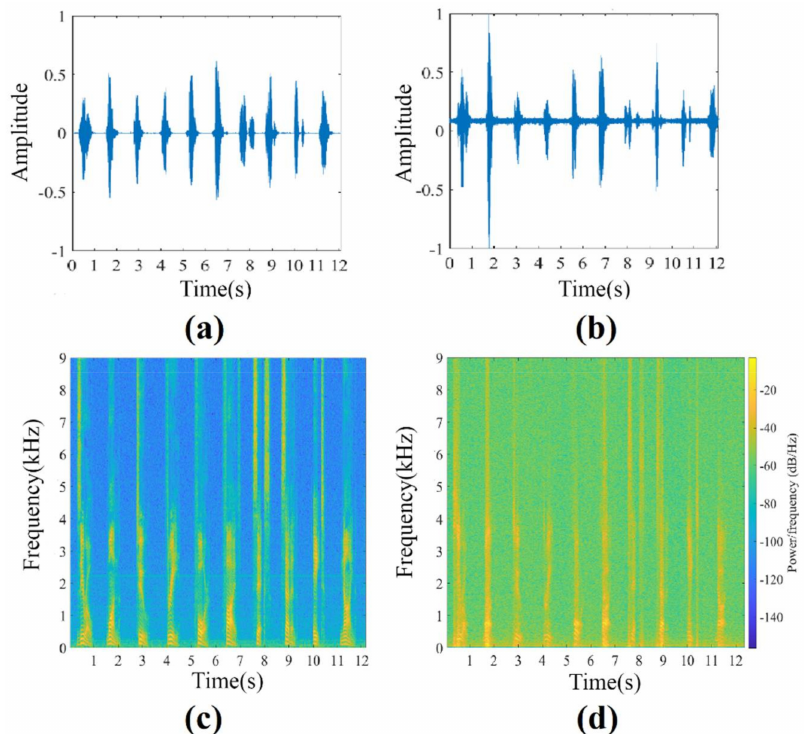
Figure 12. Experiment result of restoring human speech in real time. ( a , b ) Temporal signal of the original sound and the restored sound. ( c , d ) Spectrogram of the original and the restored sound. (see also Supplementary Materials at the end of the